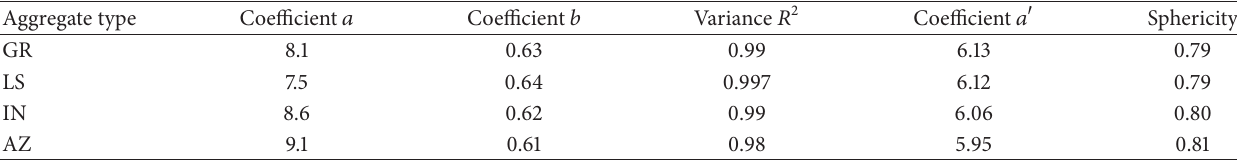
Table 1: 𝑆 - 𝑉 correlation coefficients found by Erdogan et al. [8] for four types of aggregate: 𝑎 and 𝑏 are from 𝑆 = 𝑎𝑉 𝑏 , while coefficient 𝑎 󸀠 is from 𝑆 = 𝑎 󸀠 𝑉 2/3 . Sphericity is calculated by (1).